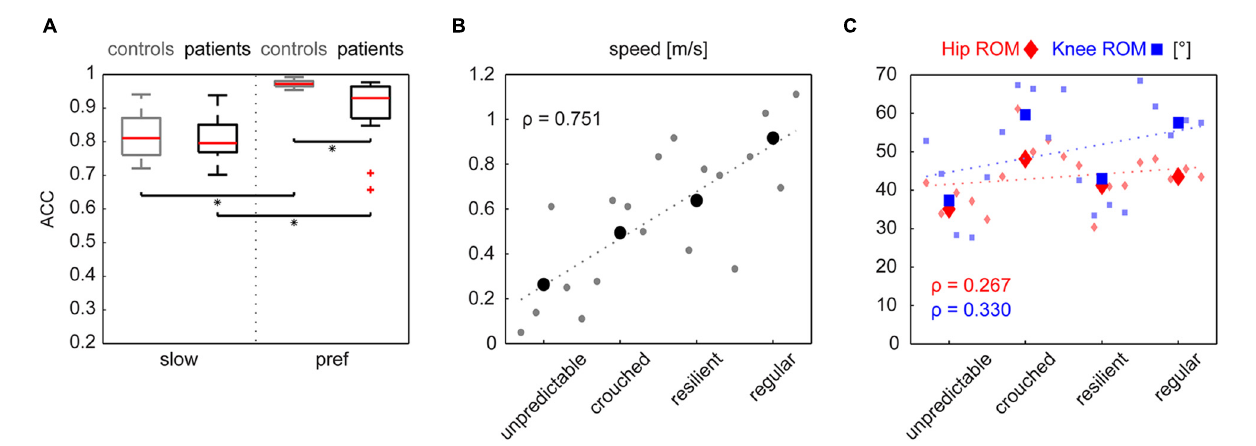
values at preferred walking speed. Statistical significance ( p < 0.0125) is indicated by an asterisk. Panel B shows the correlation indicated by Spearman’s ρ of the cyclogram ranking to preferred OG walking speed and to hip- and knee-ROMs (C) . Little dots represent single values of individual subjects while the larger symbols represent the mean value per group.